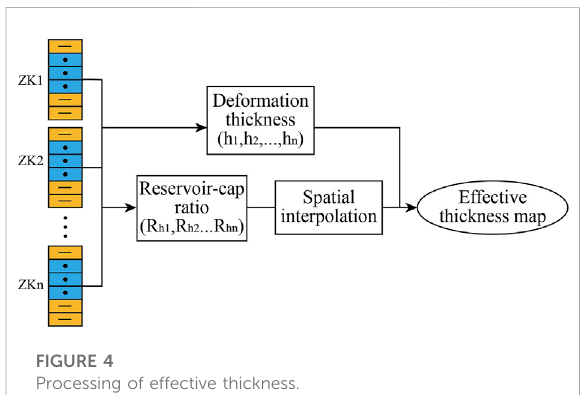
FIGURE 4 Processing of effective thickness.